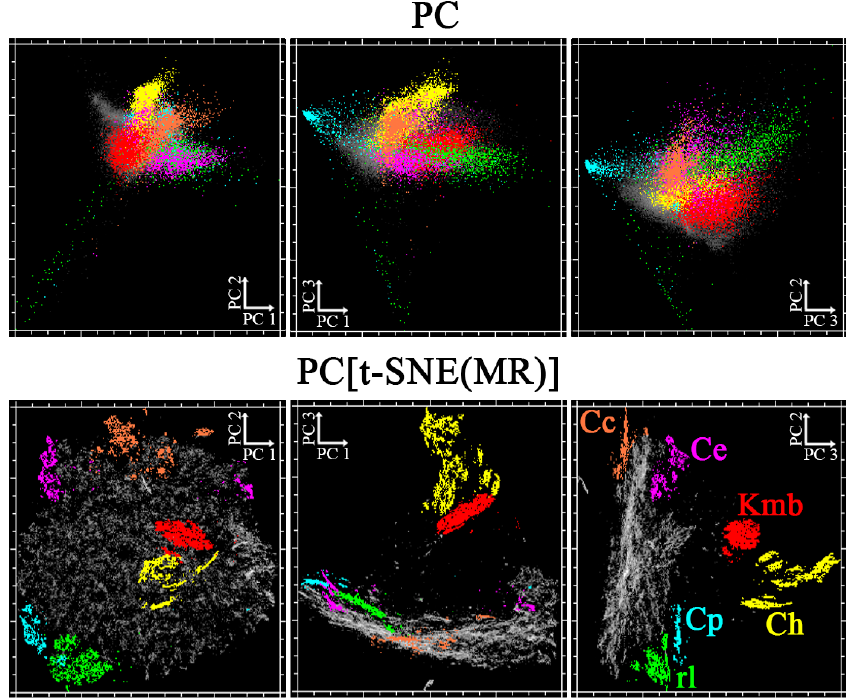
Figure 7. Spectrally distinct rock types emerge unambiguously. Compared to the reflectance-based feature space ( top ), the PC[t-SNE(MR)] feature space ( bottom ) is significantly less continuous and more clustered. Spectrally distinct rock units identified from clusters in the PC[t-SNE(MR)] feature space (colors) correspond to both boundaries of mapped geologic units and subtleties not captured by traditional geologic maps (Figure 8). The same regions projected in PC space (upper right) are clearly more diffuse, with highly ambiguous decision boundaries. This improved spectral separability has fundamental implications for geologic mapping. Clusters were found and labeled by interactive exploration of geographical pixel locations, with comparison against the geologic map and targeted field observations. Refer to earlier Figure captions and text for geologic unit descriptions.